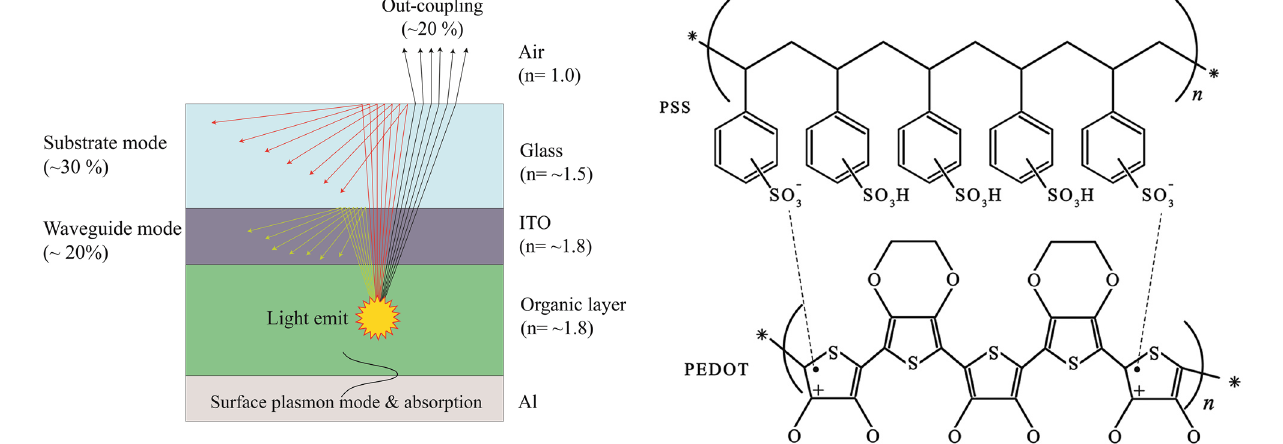
Figure 1: Various optical loss modes such as substrate mode, waveguided mode, and surface plasmon mode in an OLED.